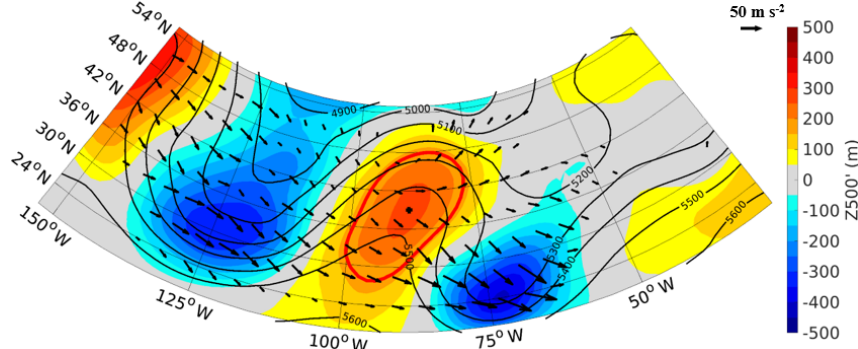
Figure 2. The 500hPa geopotential height (black contours), 500hPa geopotential height anomaly (shading), outline of blocked area (red contour), and wave activity flux vectors W (black arrows), for the first day of a blocking episode in the aquaplanet run. The black dot inside the block denotes the block centroid. Geopotential height contours are in 100m intervals. W with magnitudes less than 20m 2 s − 2 are removed.